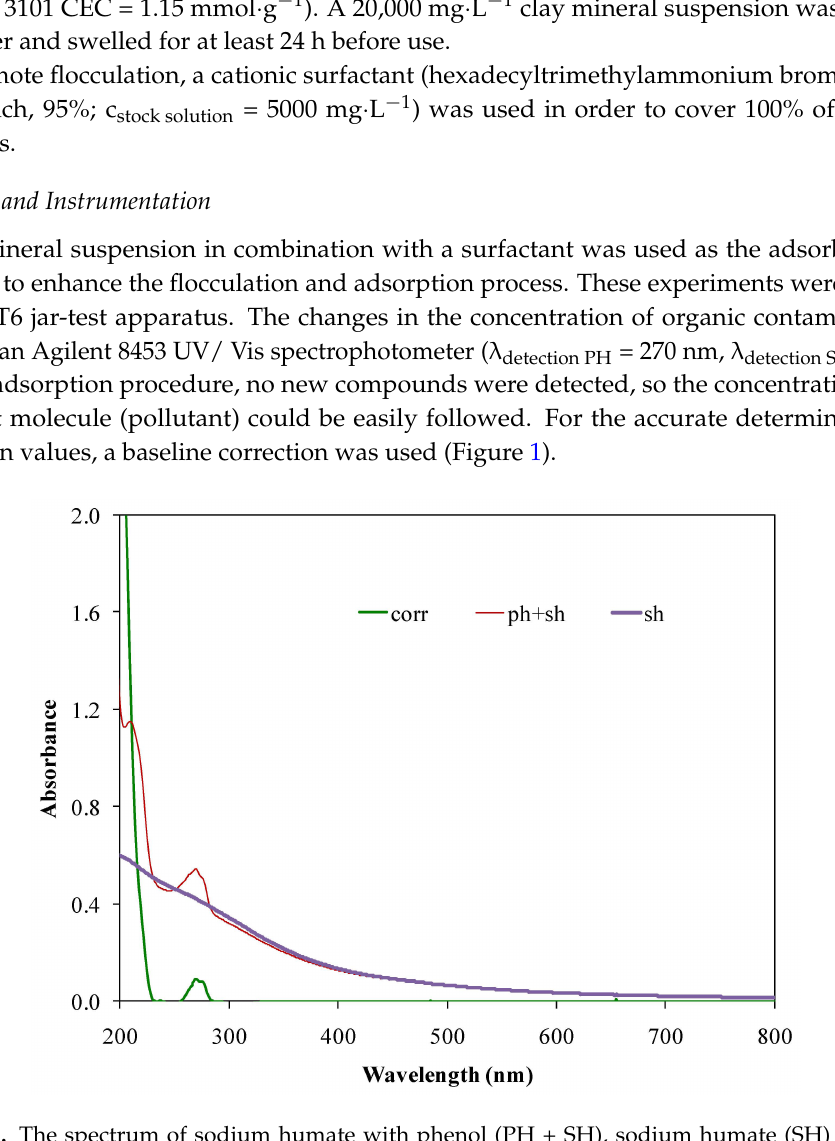
Figure 1. The spectrum of sodium humate with phenol (PH + SH), sodium humate (SH) and the corrected spectrum of phenol